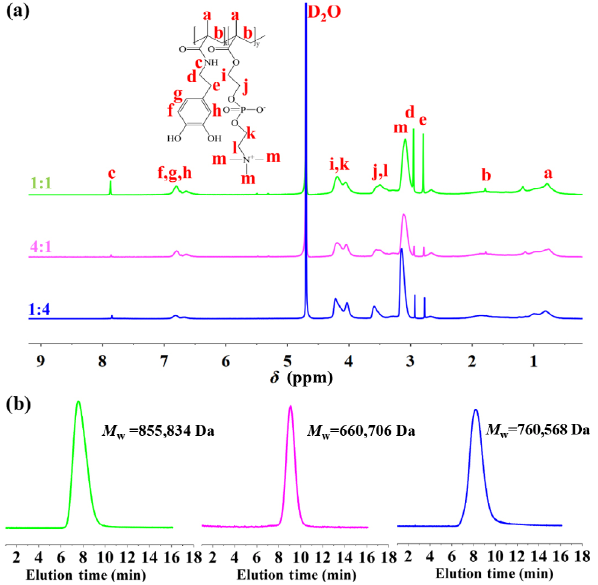
Fig. 2 Characterizations of the DMA–MPC copolymer with various mass ratios: (a) 1 H NMR spectra and (b) GPC chromatogram